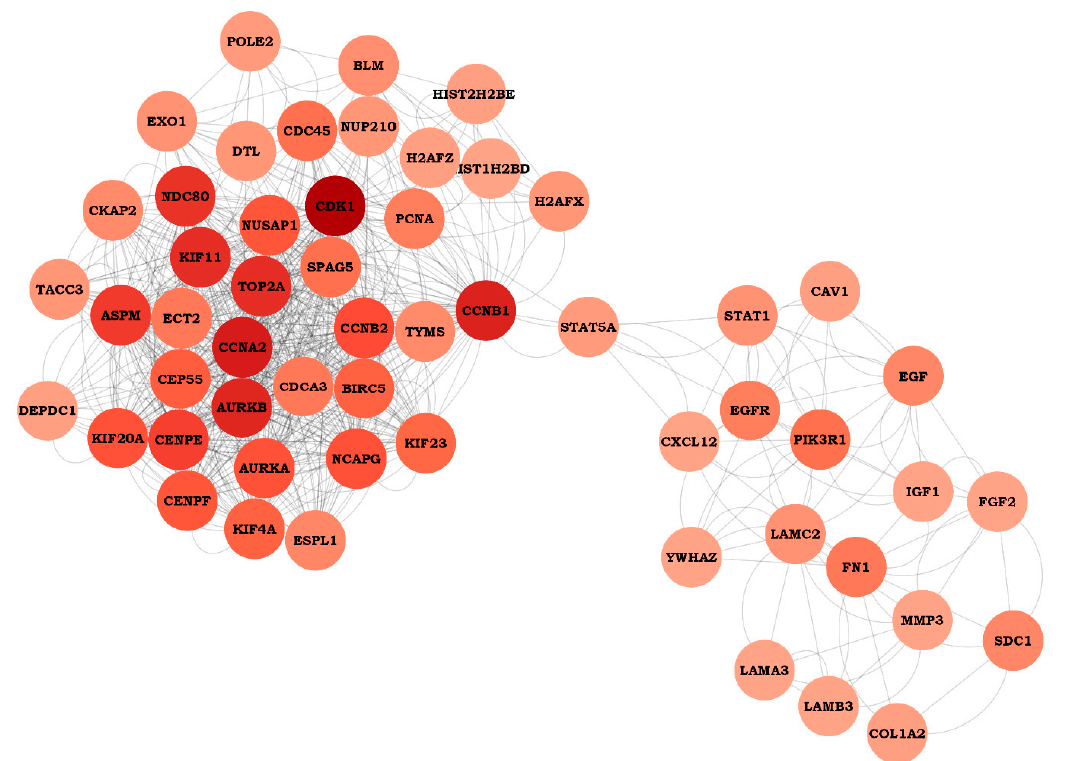
Figure 5. The PPI indicating selected nodes with at least 13 edges. Dark red indicates high degree, light red denotes low degree.